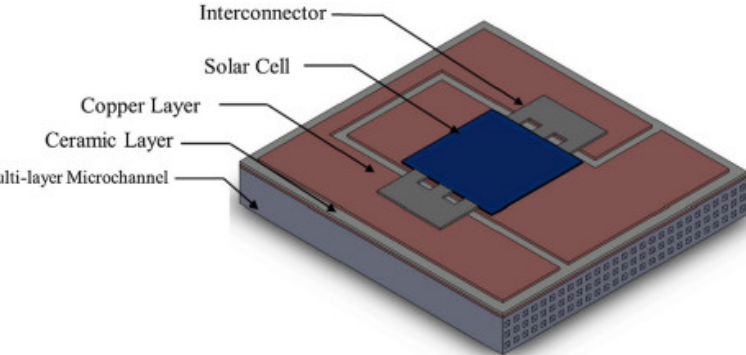
Figure 32. Schematic of a CPV receiver attached to a heat sink [134]. Reprinted with permission from Ref. [134]. 2020, Elsevier.